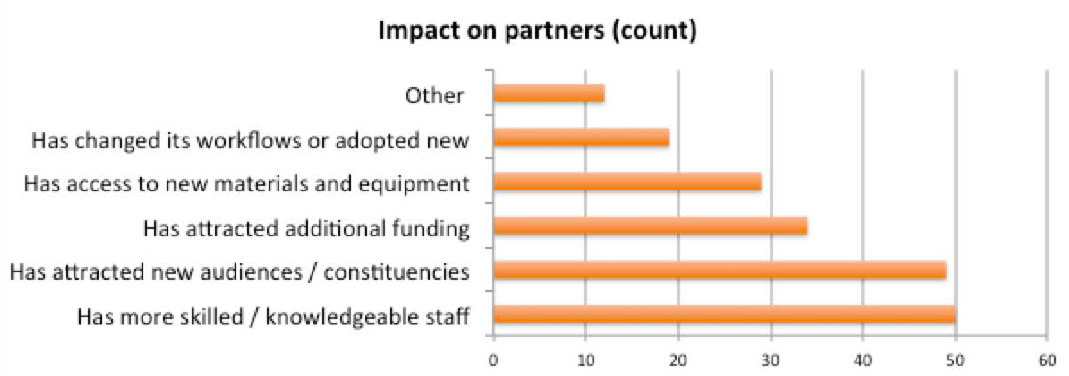
Figure 13. Impact of museum university partnerships on partner organisations as reported by survey